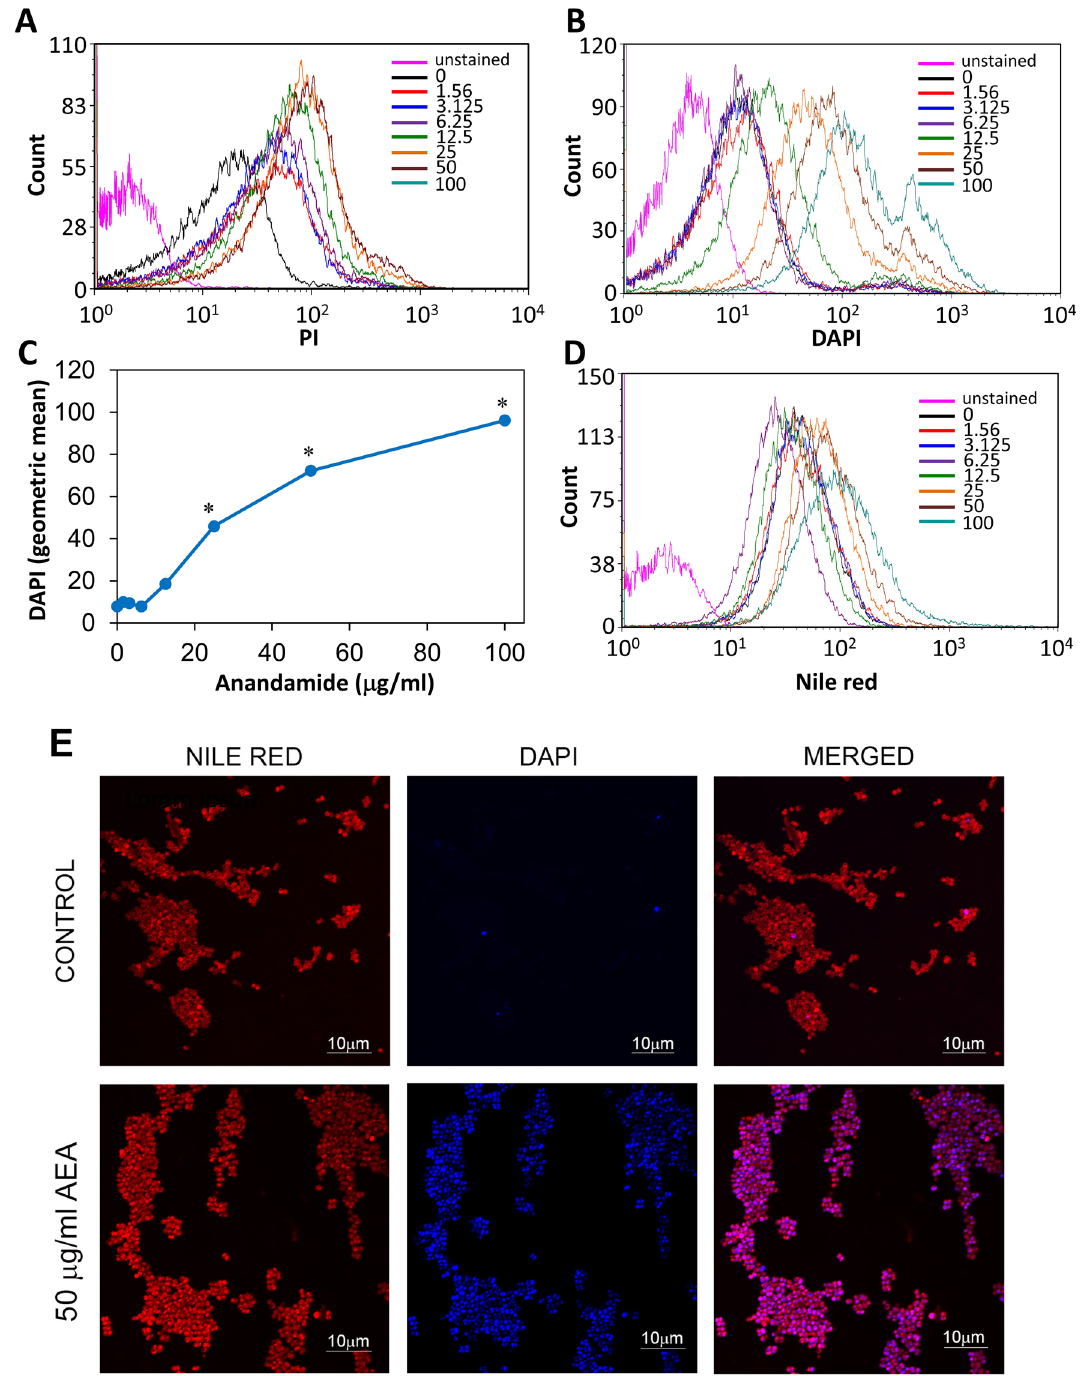
Figure 9. AEA leads to a dose-dependent accumulation of DAPI. ( A ) Propidium iodide (PI) uptake of MDRSA CI-M treated with increasing concentrations of AEA for 2 h as determined by flow cytometry. ( B ) DAPI uptake of MDRSA CI-M treated with increasing concentrations of AEA for 2 h as determined by flow cytometry. ( C ) A summary of the geometric mean fluorescence intensity of DAPI accumulation in the AEA-treated bacteria presented in B. ( D ) The fluorescence intensity of nile red membrane staining of control and AEA-treated bacteria as determined by flow cytometry. ( E ) Spinning disk microscopy of control and 2 h AEA-treated MDRSA CI-M that were stained with nile red (red fluorescence) and DAPI (blue fluorescence). *p <